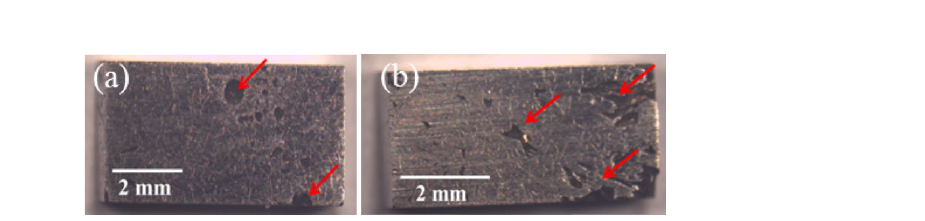
Figure 10. Stereo micrographs showing casting defects (indicated by red arrows) in the S-5 and S-6 composite